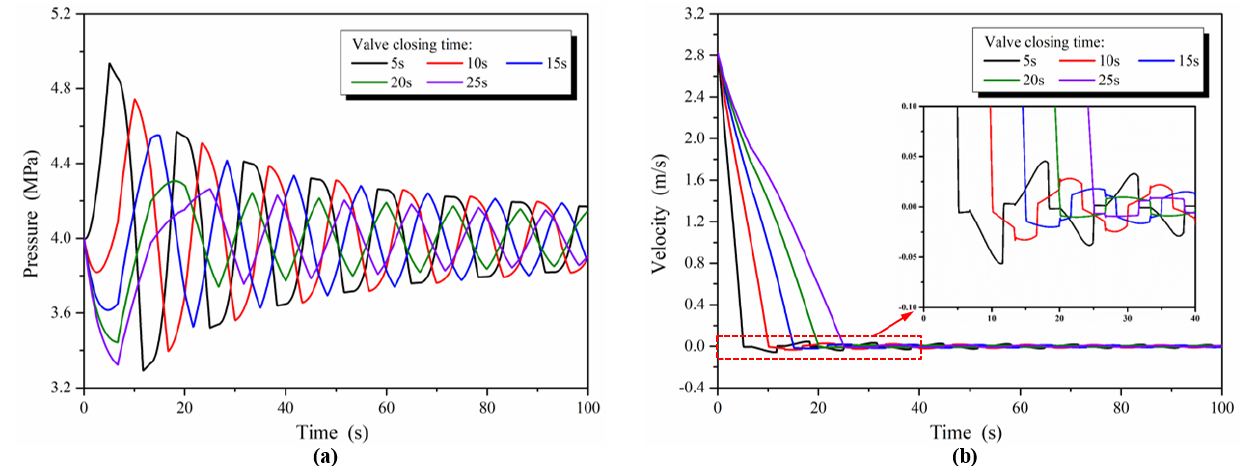
Figure 8. Influence of valve closing time on pressure and velocity fluctuation at the end of a pipeline: ( a ) represents pressure response; ( b ) represents velocity response.